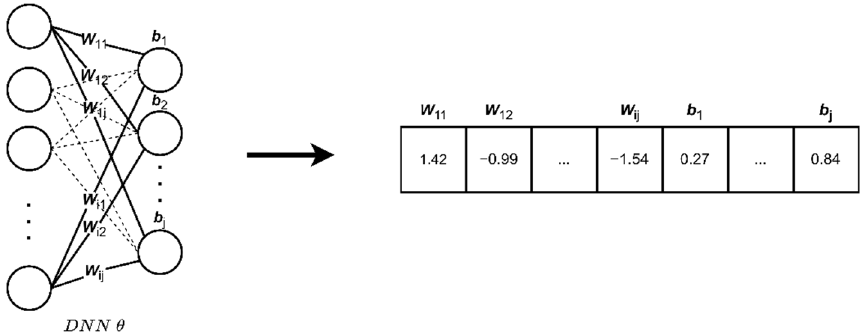
Figure 1. Example of DNN encoding.